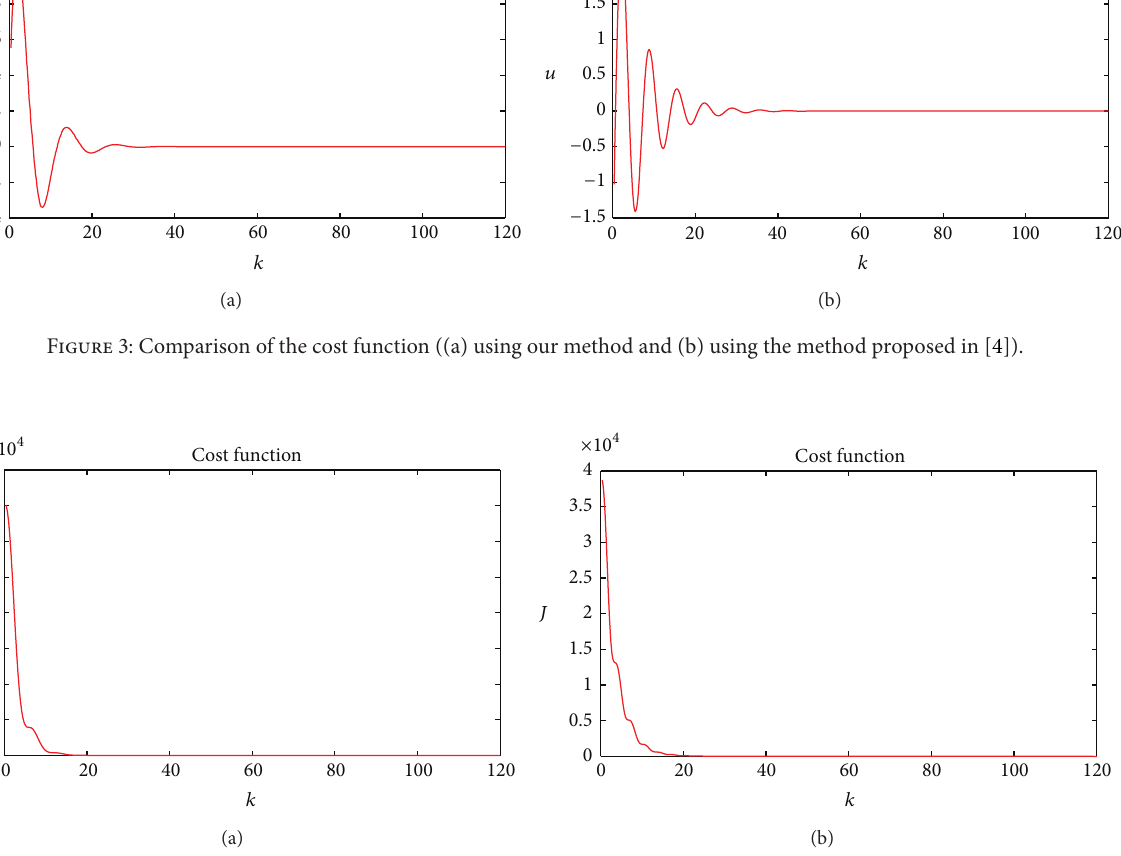
Figure 4: Comparison of the cost function ((a) using our method and (b) using the method proposed in